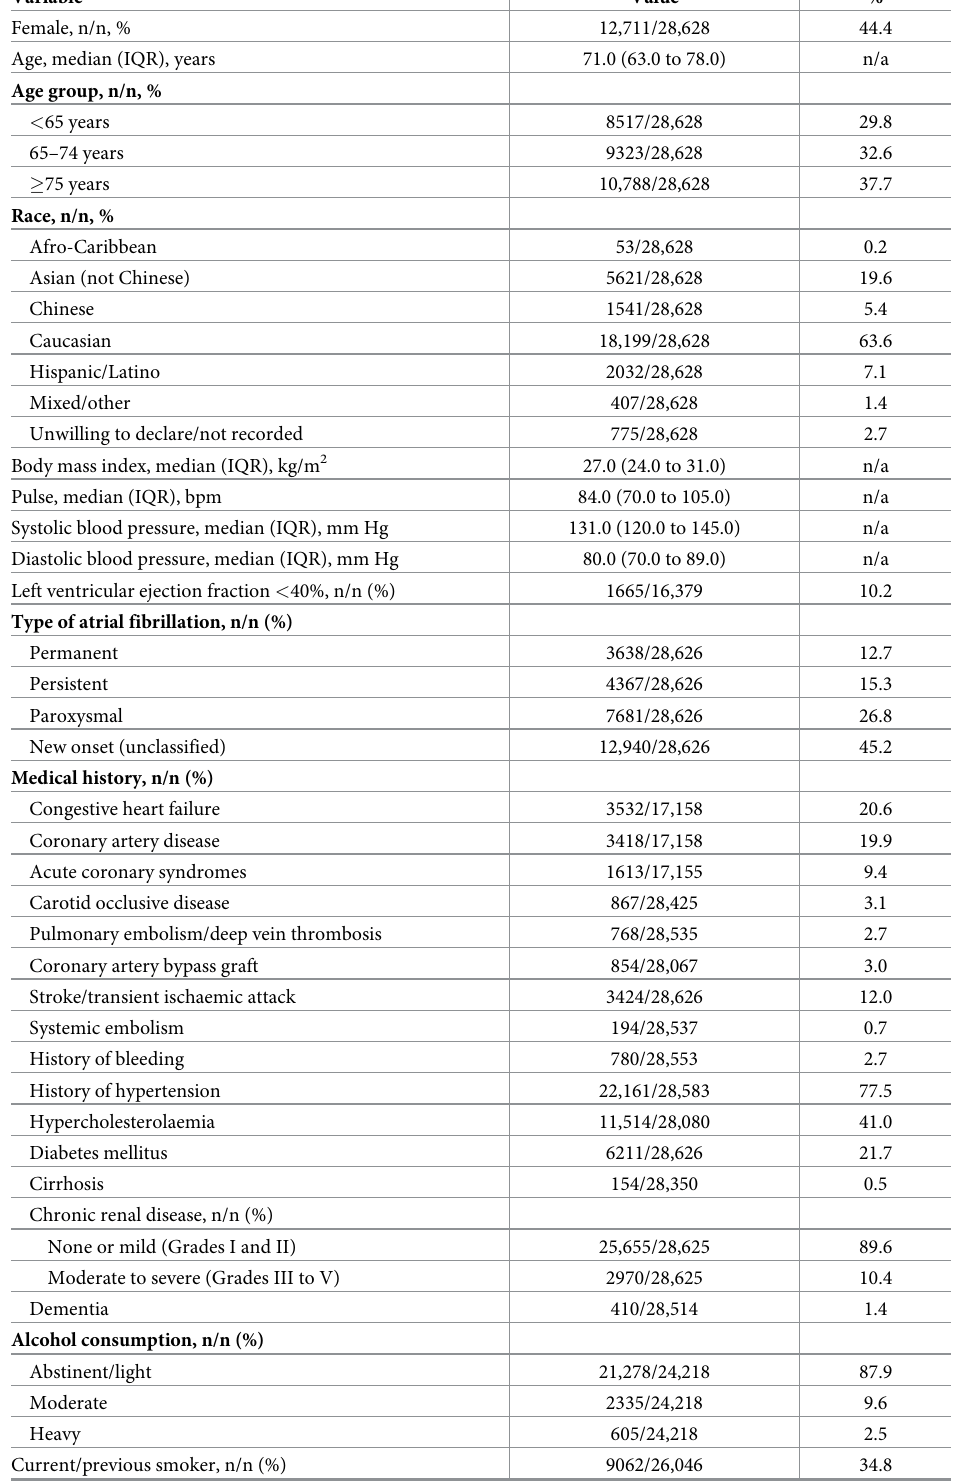
Table 1. Baseline characteristics of all patients (N =